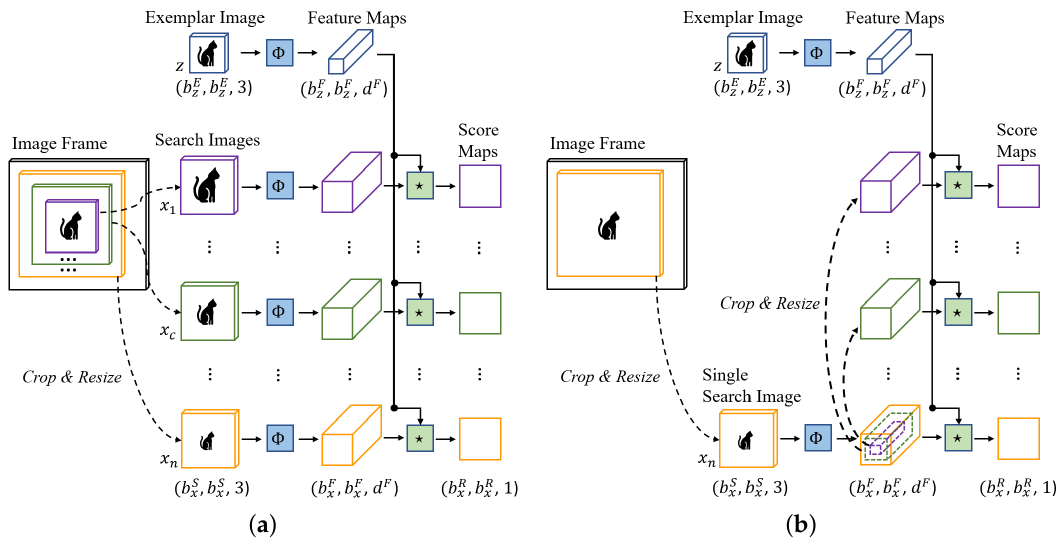
Figure 1. The feature map extraction process of fully convolutional Siamese network (SiamFC) ( a ) and the proposed framework ( b